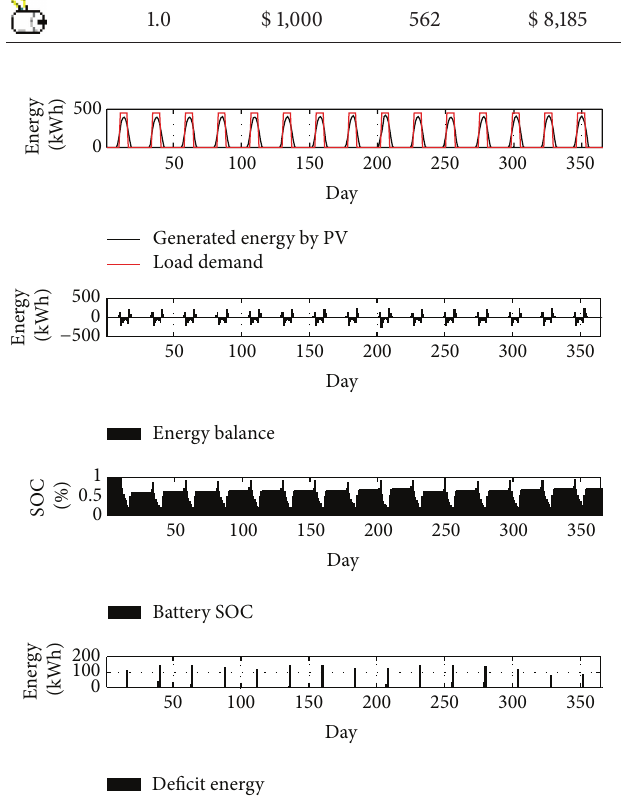
Figure 7: Proposed system hourly performance sample.